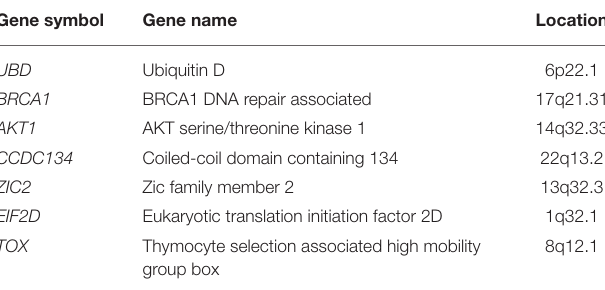
TABLE 2 | Gene information for the common DEGs between drug-treated and drug-naive participants from the microarray